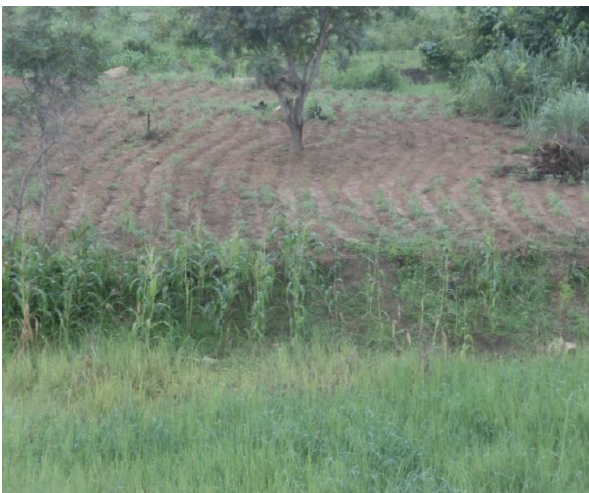
Figure 4. Photo 1 : Disposition des billons de façon parallèle à la pente à Toucountouna. Prise de vue : P. Ouassa, Août